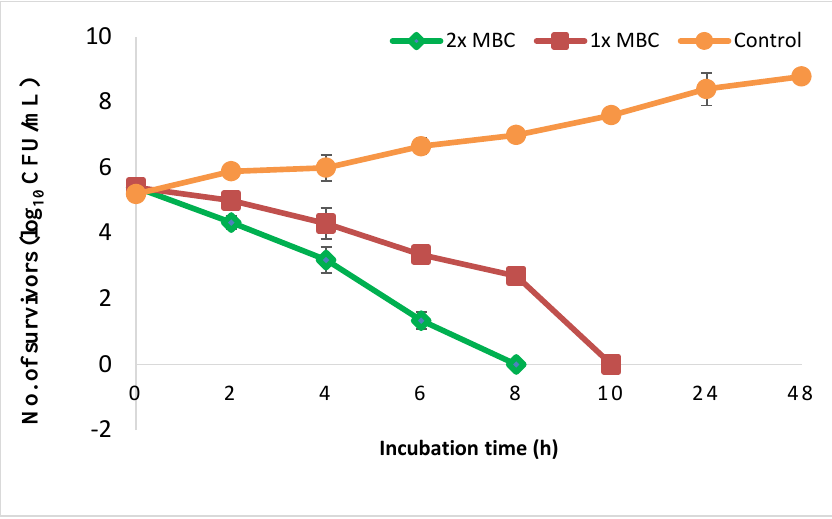
Figure 4. Time-kill assay of the test pathogen was performed in the absence or presence of pomegranate extract at 1× MBC or 2× MBC.